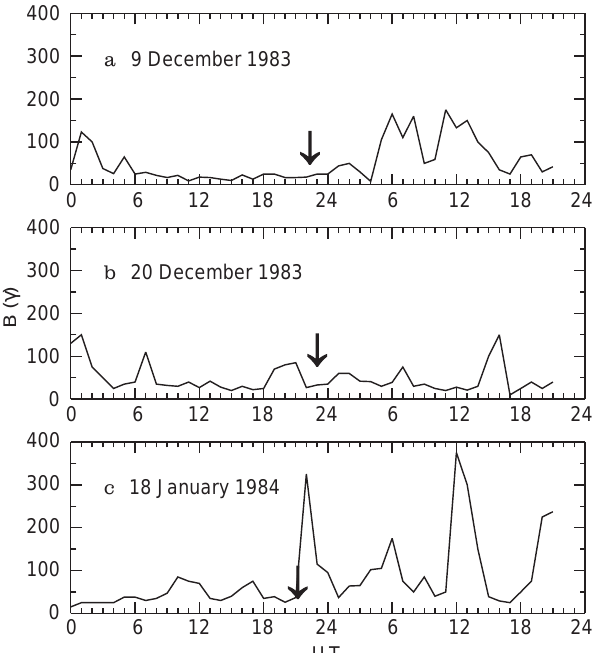
Fig. 2. Variations of the horizontal magnetic field at Heiss Island on the day of the rocket flights during the first series (Fig. 1a) of the mesospheric electric field measurements. Arrows indicate the time of the